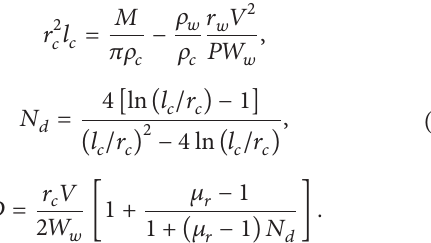
Figure 1: ACS (CubeSat-class nanosatellite with three reaction wheels and three torque